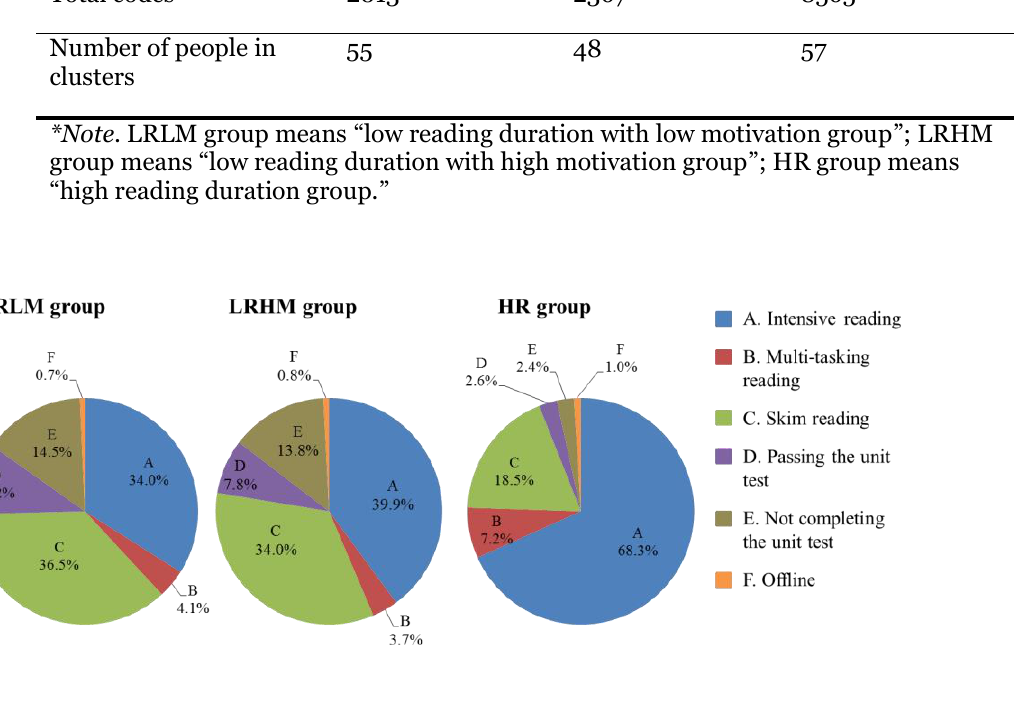
Figure 4. Pie chart of behavior percentage in each